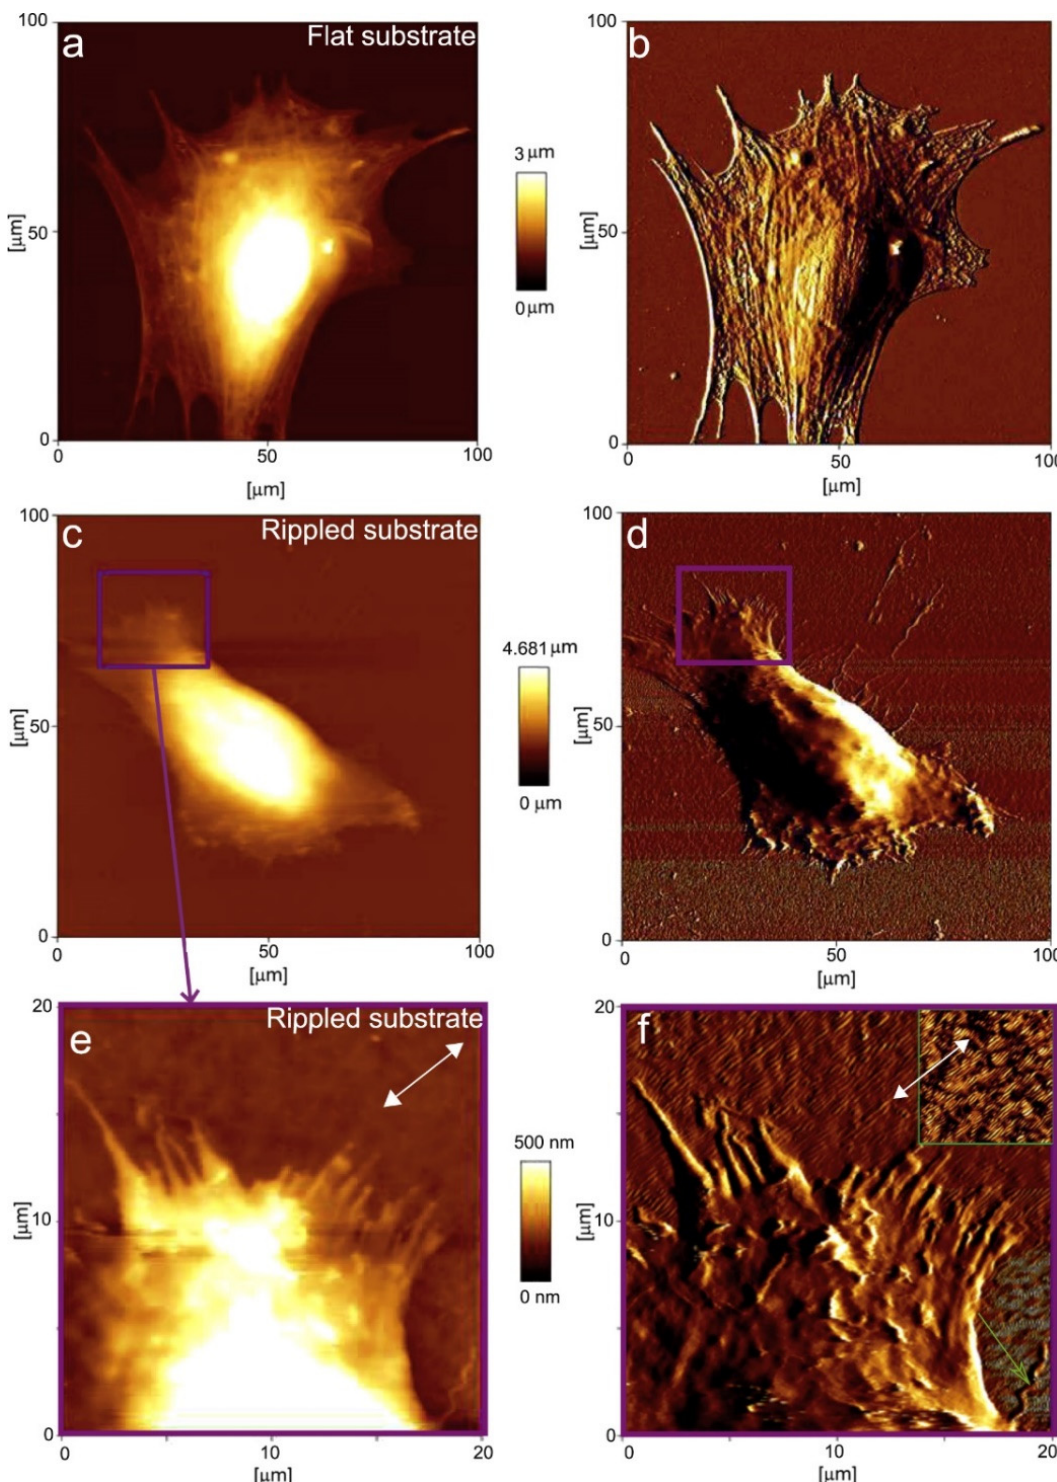
Figure 9. AFM images (topography—left and vertical deflection—right) of NSCs on ( a , b ) a flat and ( c , d ) a rippled surface. Images ( e , f ) are zooms of the highlighted areas in ( c , d ), respectively. The white arrows indicate the ripple direction. Republished with permission of IOP Publishing, Ltd., from Ref. [131]; permission conveyed through Copyright Clearance Center,